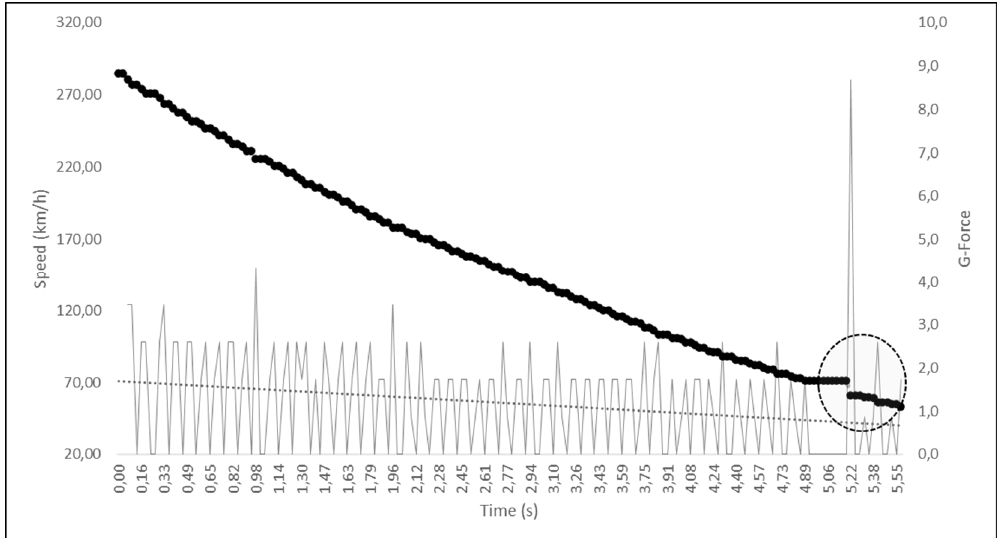
Figure 8. Rossi’s actual speed and instantaneous G-Force peak from point A to the point where he narrowly missed colliding with Morbidelli’s bike. The circled area shows the moment in which Rossi braked, reducing his speed by 10 km/h in 0.03 s.